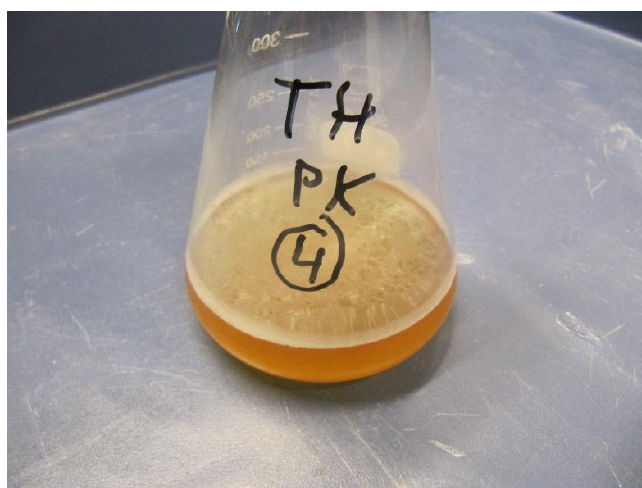
Figure 2. Film produced by Pichia kluyveri over grape juice.